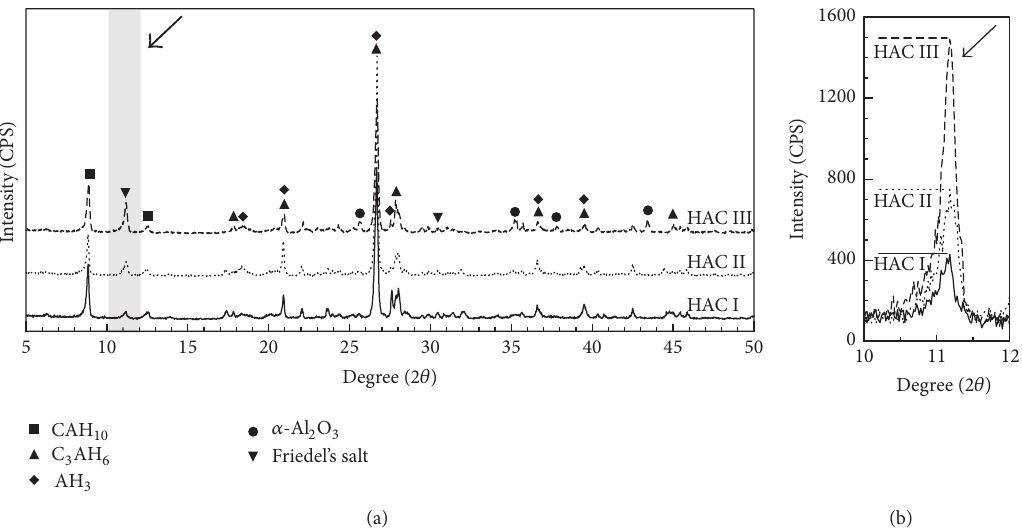
Figure 5: X-ray diffraction pattern of cement paste with different HAC types after 100 days of exposure to 1.0 M NaCl solution. (a) Hydration products and (b) Friedel’s